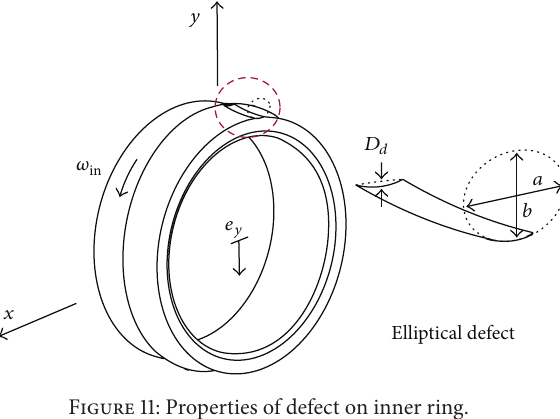
Figure 11: Properties of defect on inner ring.